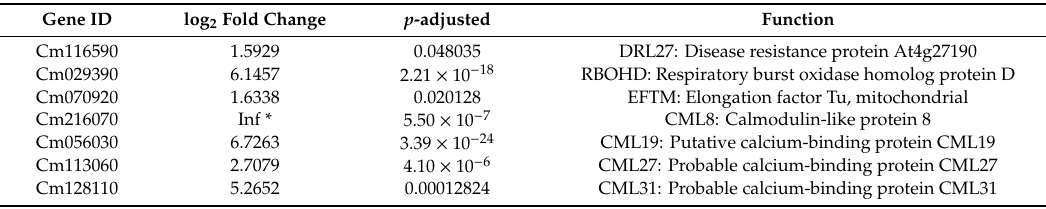
Table 5. E ff ect of the genes involved in plant-pathogen interactions in CEVd-infected citron